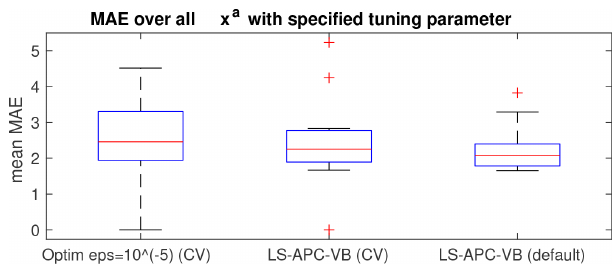
Figure 8. Box-and-whisker plots of the MAE averaged over all ex- plored prior source terms, with the tuning parameter settings deter- mined by CV for the optimization method (left) and the LS-APC- VB method (middle), as well as for the LS-APC-VB method using a default err x setting of 10 0